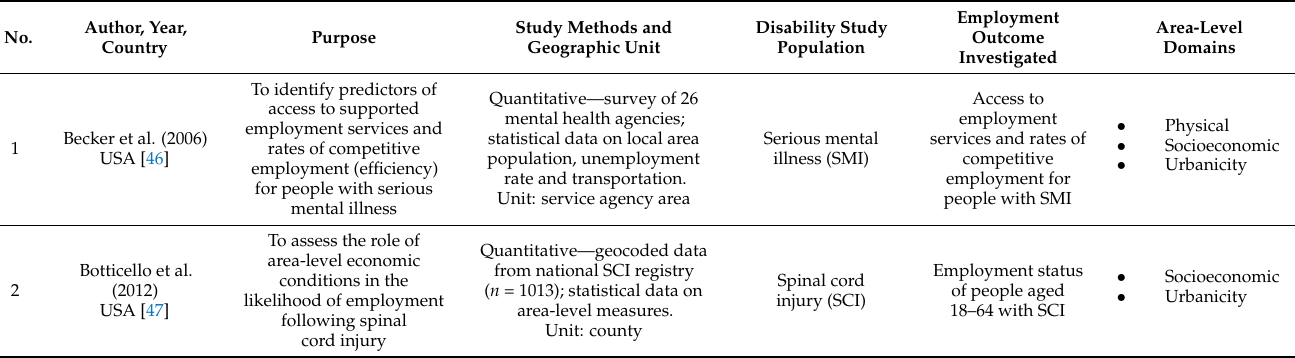
Table 1. Summary of included